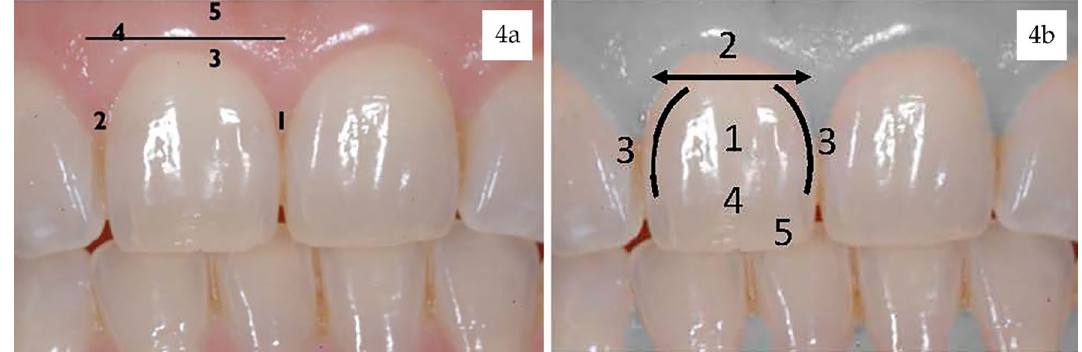
Figure 4. PES/WES Evaluation. ( a ) Parameters evaluated by WES and ( b ) parameters evaluated by